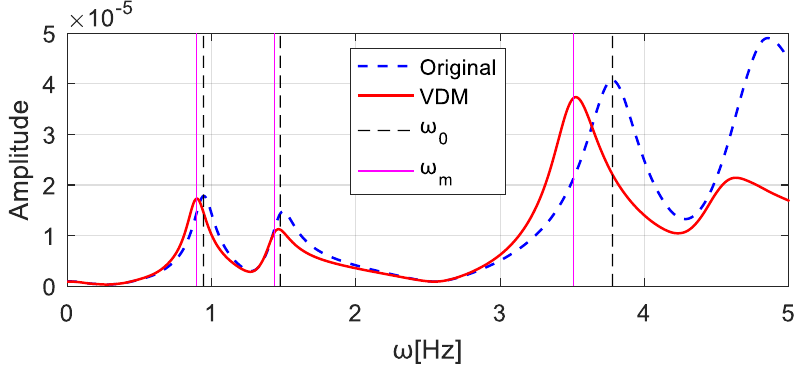
Figure 15. Frequency responses of the structure in different cases.